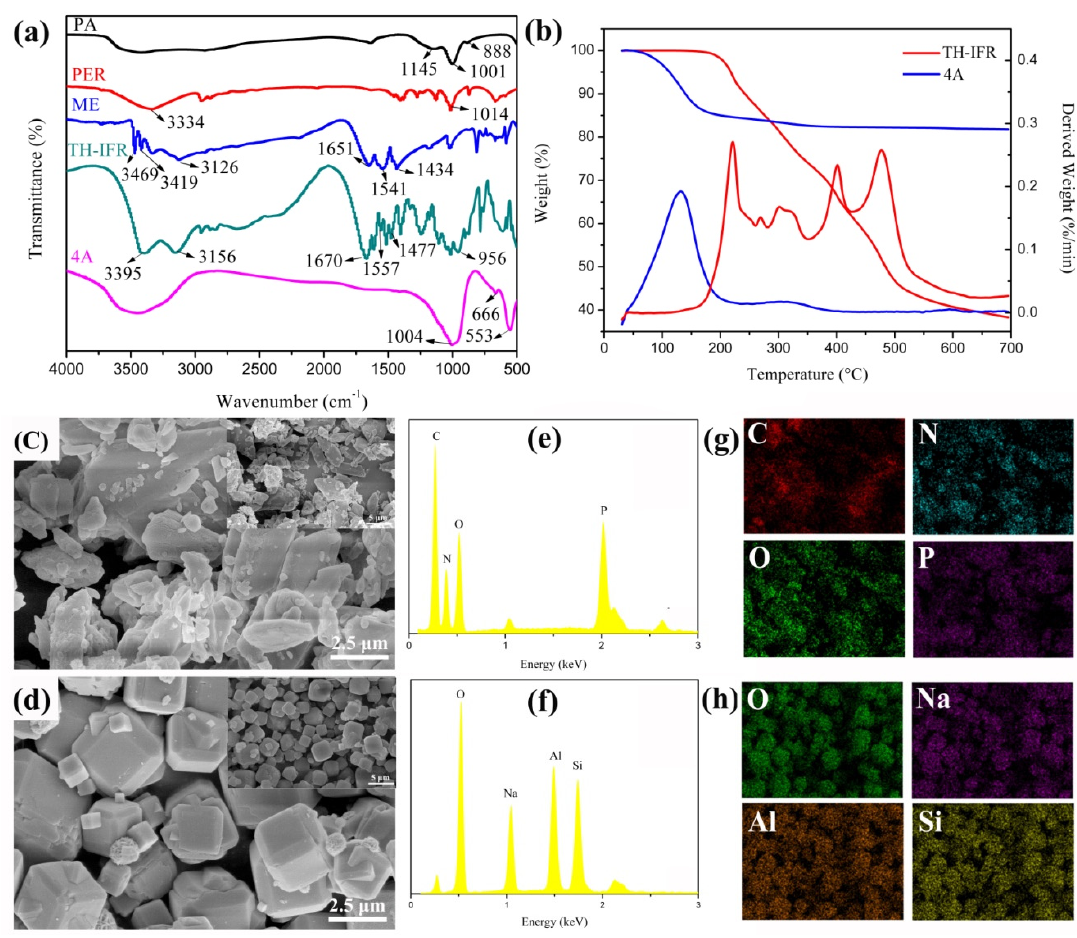
Figure 2. FT-IR spectra of PA, PER, ME, TH-IFR and 4A ( a ); TGA curves of TH-IFR and 4A ( b ); FESEM images of TH-IFR ( c ) and 4A ( d ); EDS spectra of TH-IFR ( e ) and 4A ( f ); elemental mapping images of TH-IFR ( g ) and 4A ( h ).